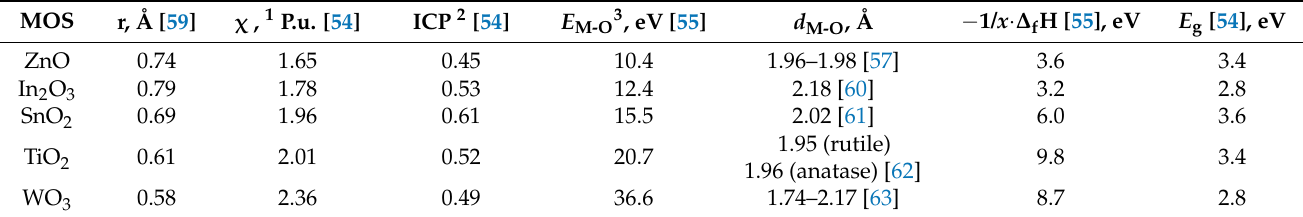
Table 1. Parameters of n -type metal oxide semiconductors (MOS): cationic radius r, electronegativity χ and ionic-covalent parameter ICP; metal-oxygen bond energy E M-O and bond distance d M-O ; negative formation enthalpy per oxygen atom − 1/ x · Δ f H; bandgap width E g .